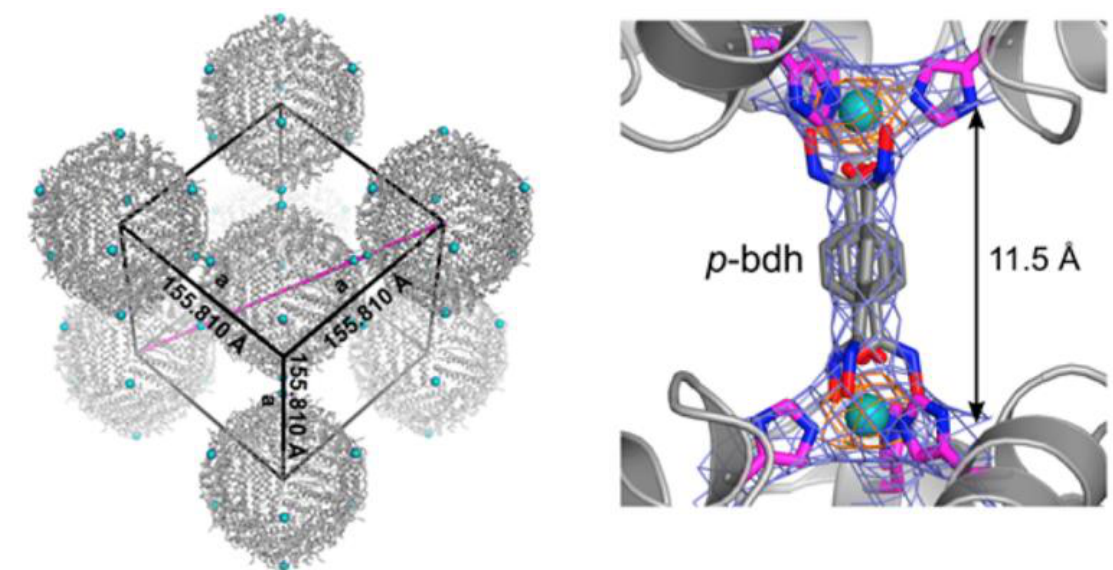
Figure 11. Crystal structure of Zn-ferritin-bdh , bdh connection between Zn-ferritin SBUs [243]. Adapted from ref. [243] with permission.